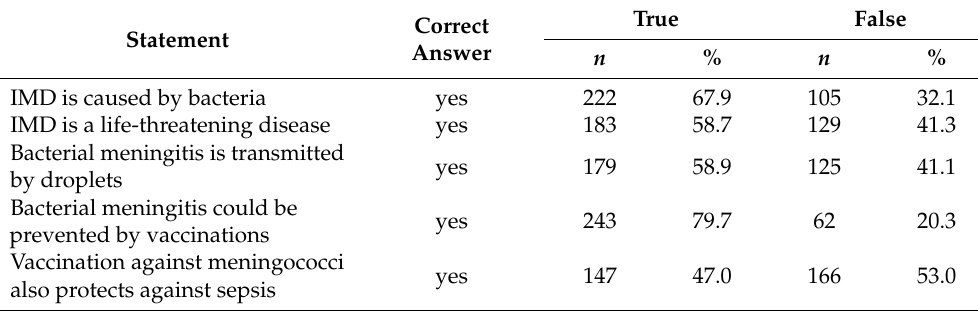
Table 2. Parental knowledge about IMD; Poland, 2018, n =